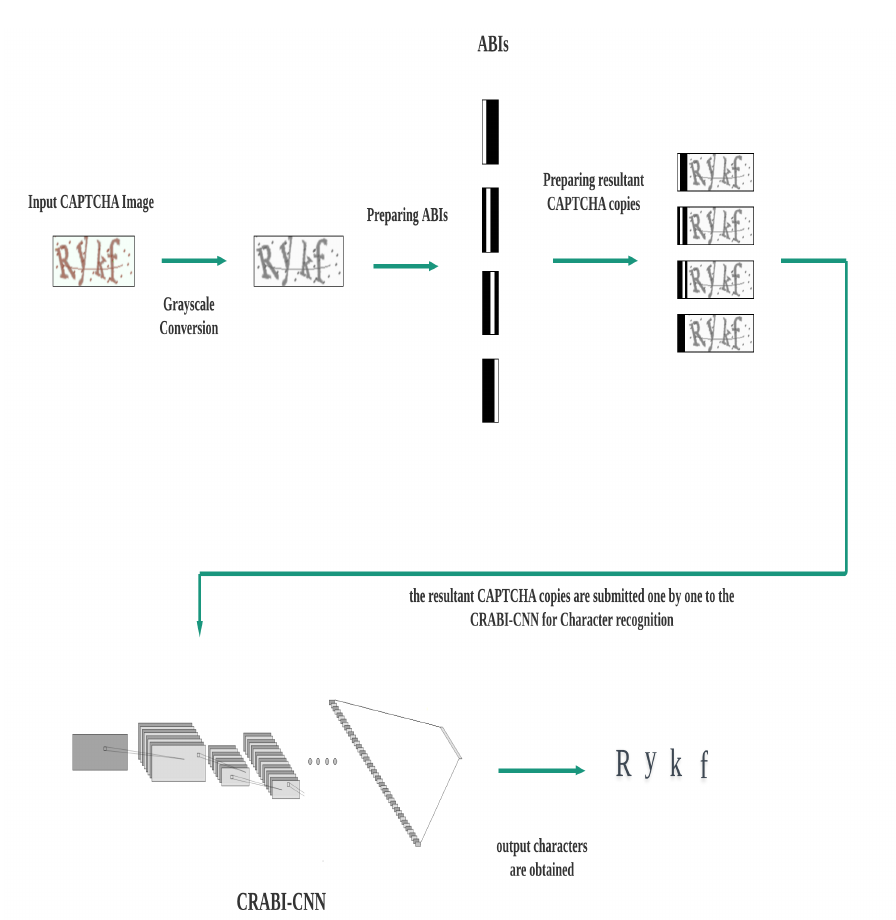
Figure 4. Framework description of the whole pipeline in testing